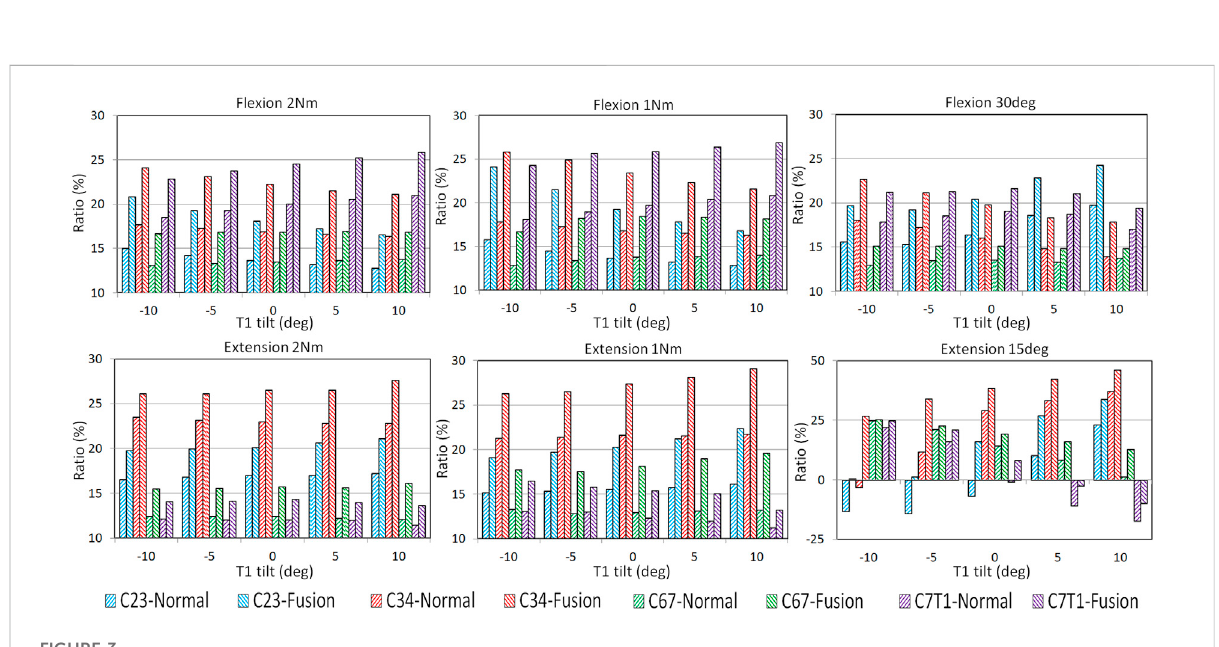
FIGURE 3 FSU ROM ratios of pre- and post-operative C2 – T1 FE models with different T1 tilts under fl exion and extension